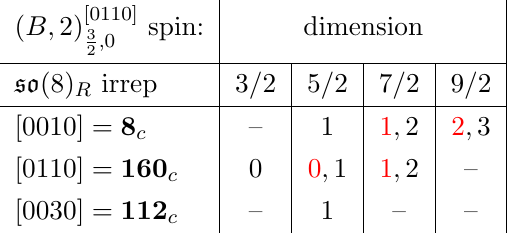
Table 13 . All possible conformal primaries in S 2 (cid:2) S 3 corresponding to the ( B; 2) [0110] formal